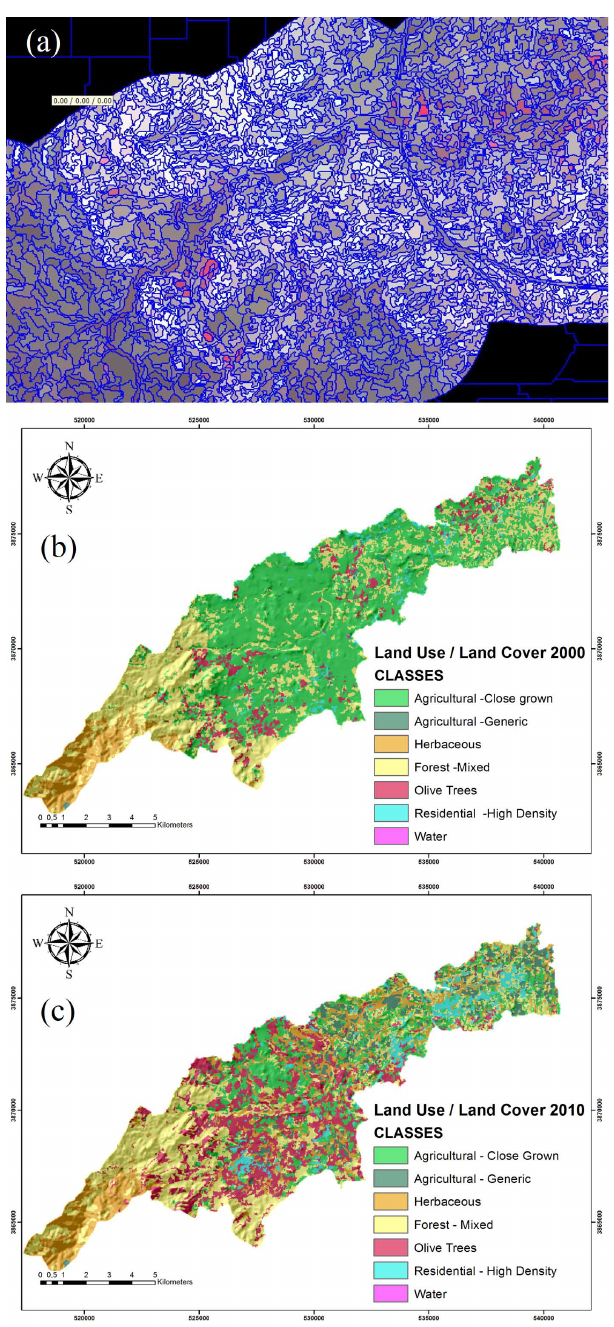
Fig. 4. (a) Image segmentation of ASTER 2010 image, (b) LULC map of the study area for 2000, and (c) LULC map of the study area for 2010.